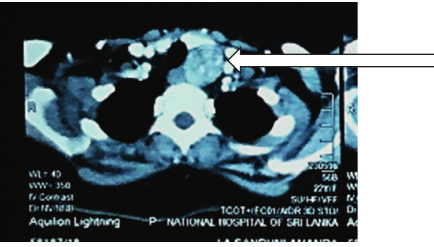
Figure 2: CT neck showing the left side parathyroid mass.